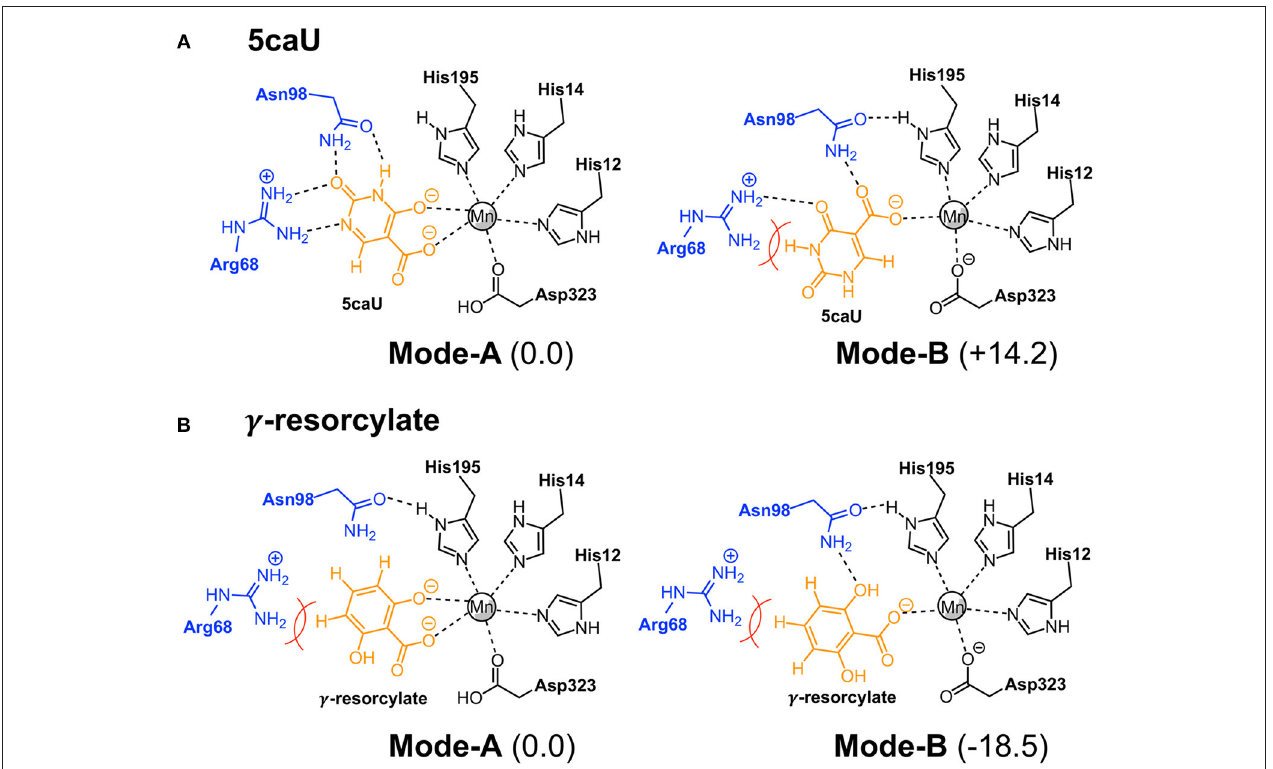
FIGURE 6 | Binding modes of 5caU (A) and γ -resorcylate (B) in IDCase. Relative energies for each substrate are given in